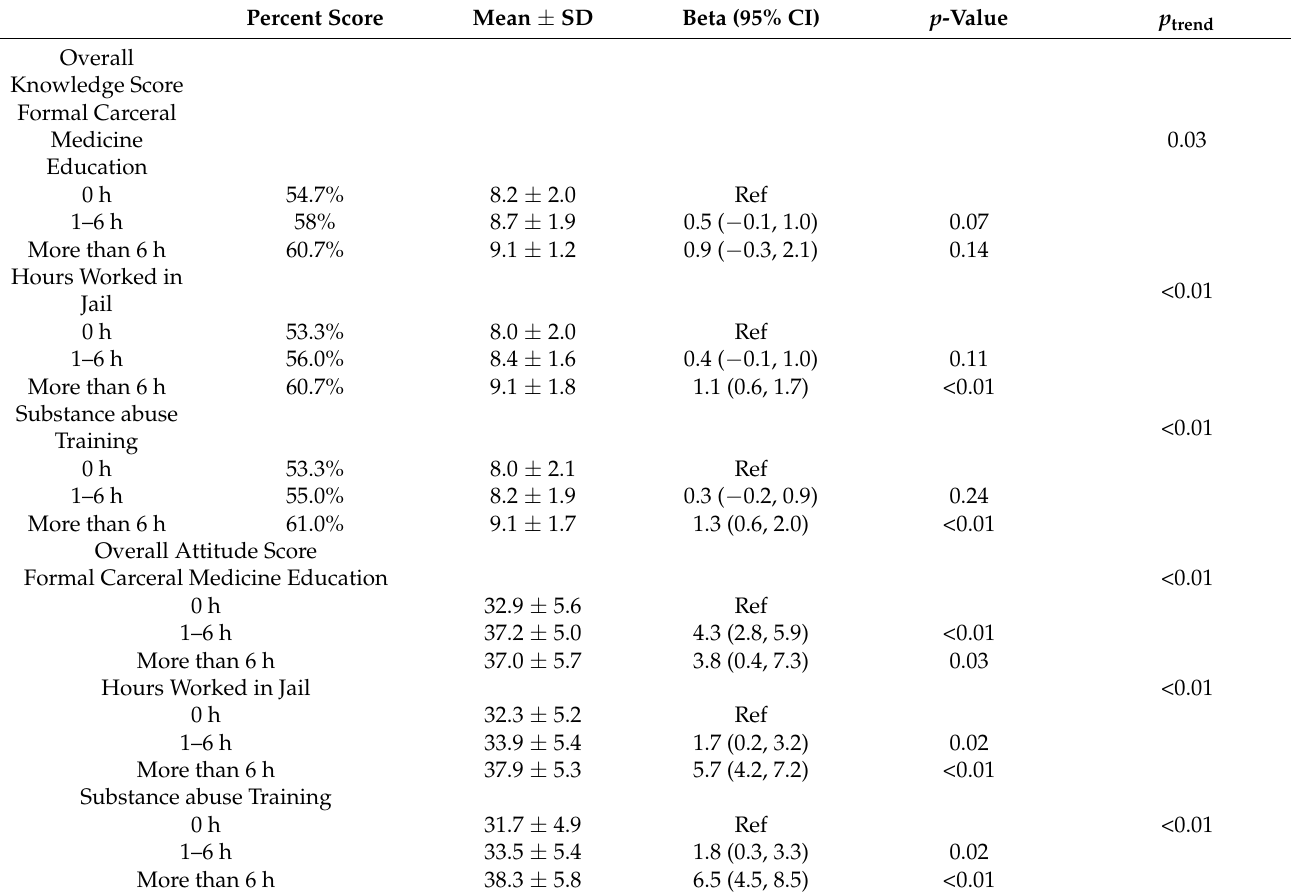
Table 2. Univariate Associations between Didactic and Experiential learning and assessment score.